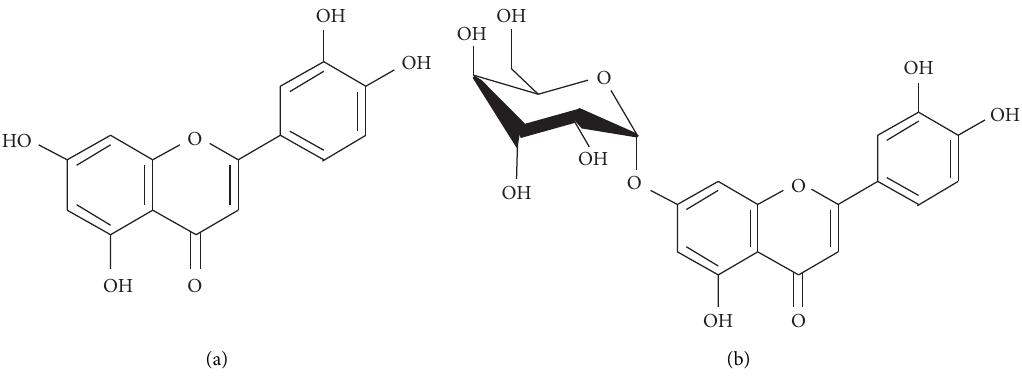
Figure 1: Structures of luteolin (a) and luteoloside